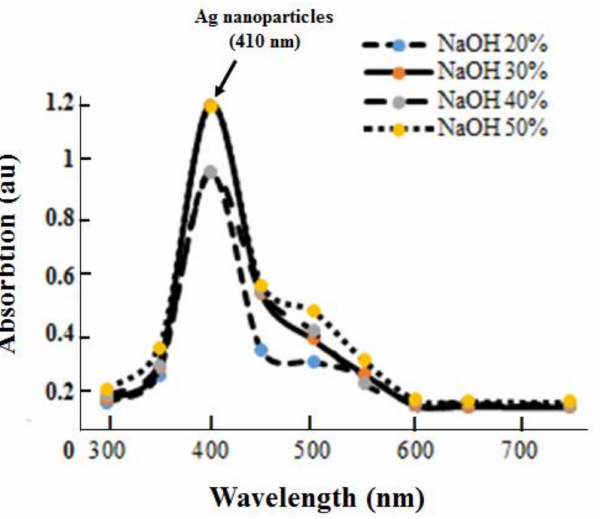
Figure 3. UV–Vis absorbance spectra of the synthesized silver–chitosan composite spheres at various concentrations of NaOH